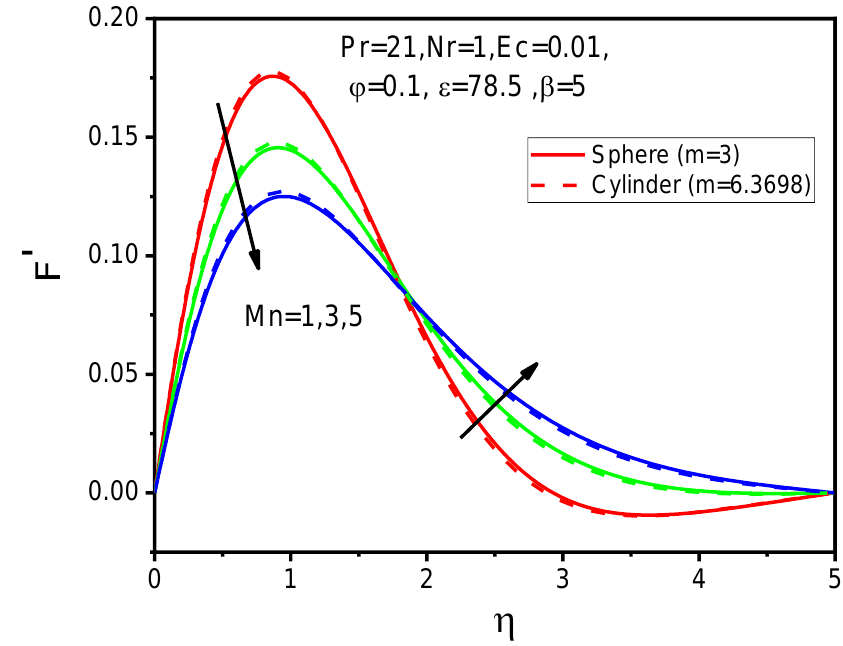
Figure 8. (Case b): Variations of F (cid:48) for Mn = 1, 3, 5 against η .